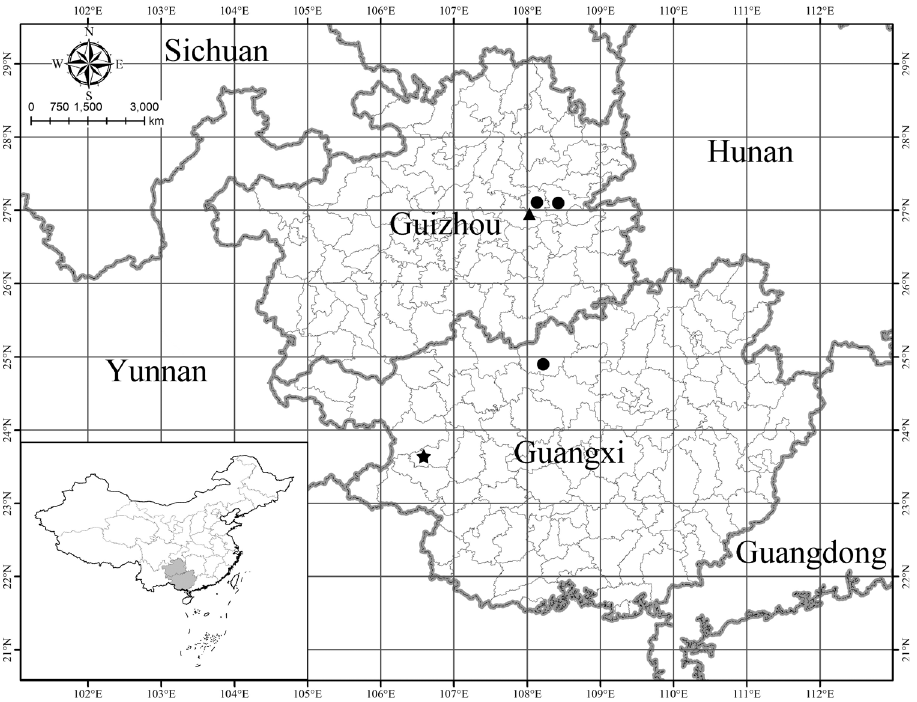
Figure 3. Distribution map of Elatostema huanjiangense (circle), E. setulosum (star) and E. tetracepha- lum